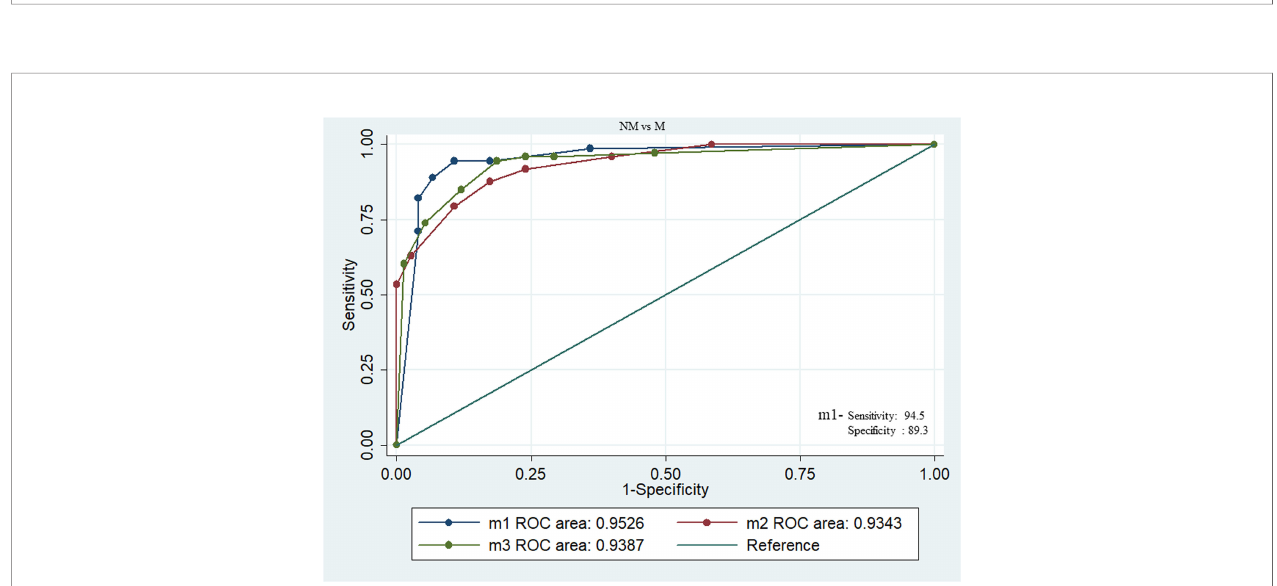
FIGURE 4 | Combined ROC between NM and M breast cancer patients with panel of proteins m1(phospho-LIMK1, phospho-p38 a , and p38 a ), m2 (LOX5, Rac1, and phospho-p38 a ), m3 (LOX5, phospho-p38 a , and phospho-co fi lin1). Among these combination m1 showing excellent AUC value of 0.95, speci fi city 94.5%, sensitivity 89.33%, PPV 89.6%, and NPV